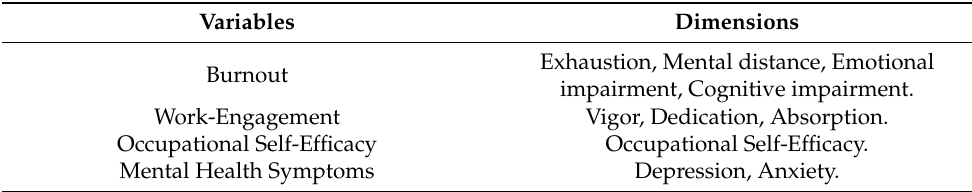
Table 1. Variables and considered